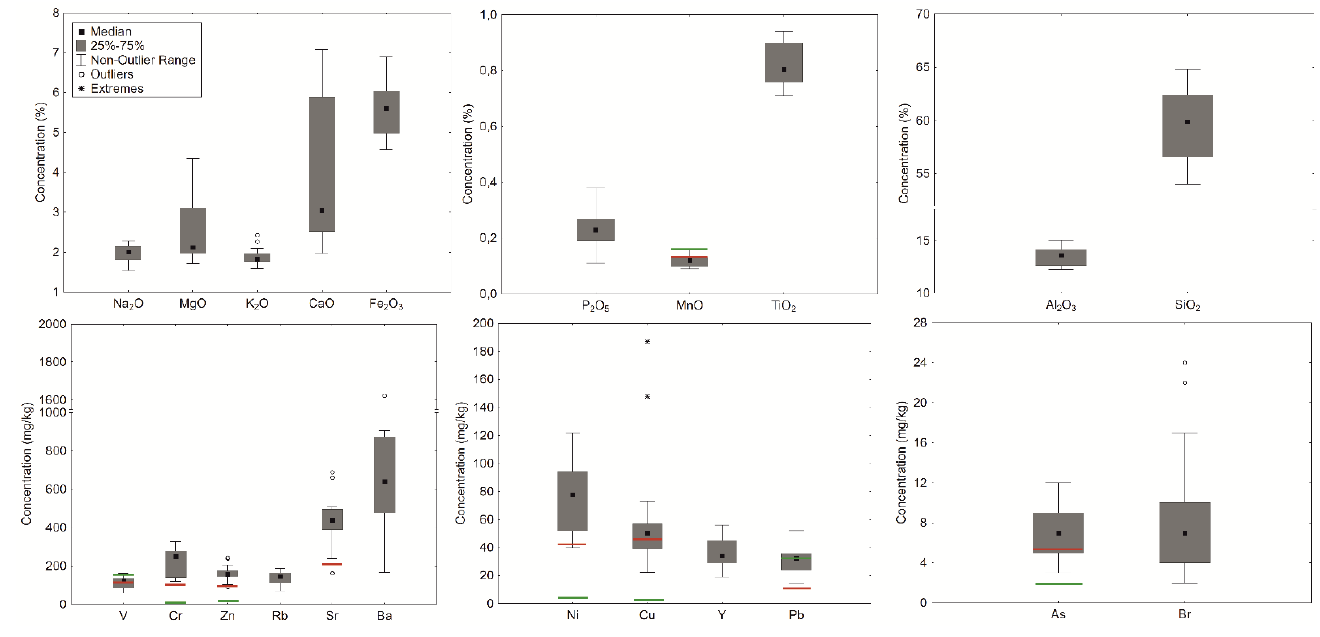
Figure 5. The results of the soil samples analysis by the WDXRF (Na 2 O, MgO, Al 2 O 3 , SiO 2 , P 2 O 5 , K 2 O, CaO, TiO 2 , MnO, Fe 2 O 3 ), and TXRF (V, Cr, Ni, Cu, Zn, As, Br, Rb, Sr, Y, Ba, Pb) techniques. Note: The red line presents the background values; green line — maximum permissible concentration.